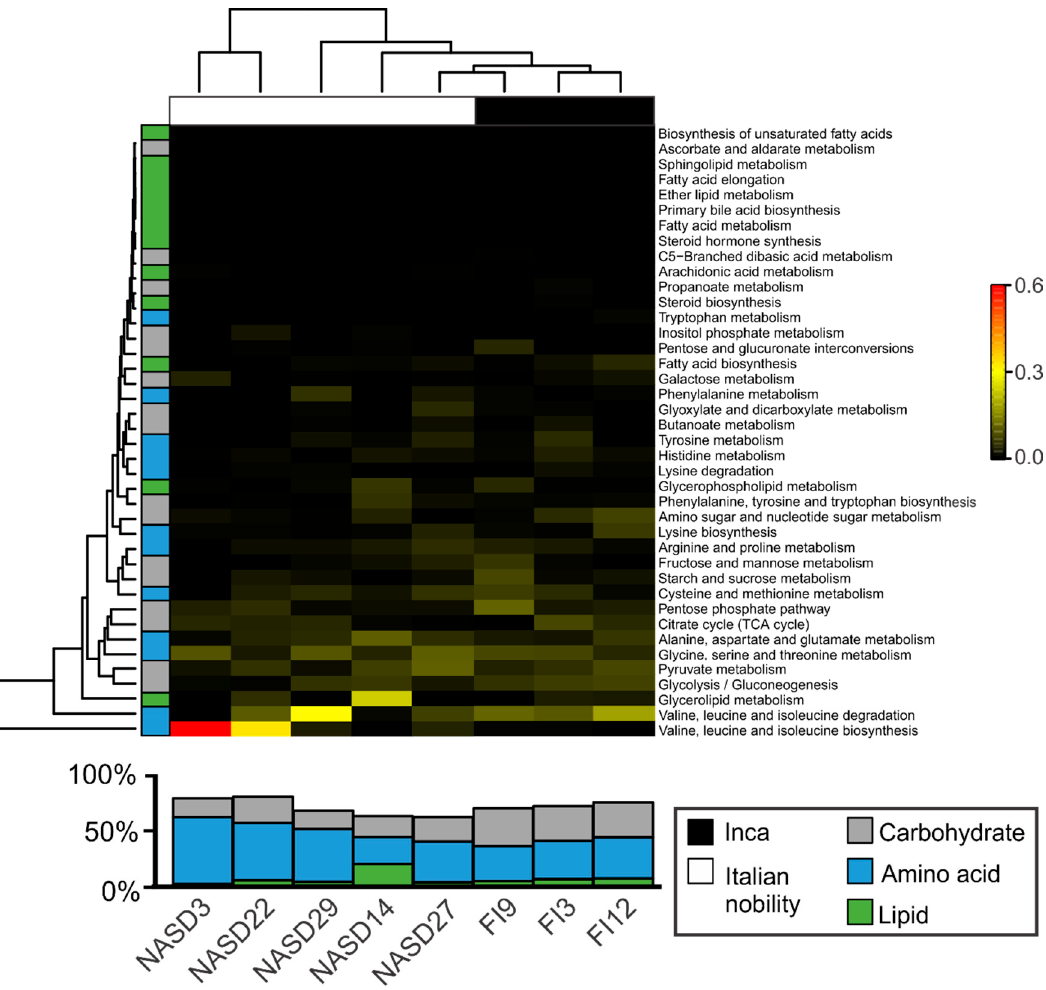
Figure 3. Characterization of the gut functional profiles associated with carbohydrate, amino acid and lipid metabolism in the pre-Inca/Inca and Italian nobility mummies. The top panel shows a heatmap of the Euclidean distances of the Kegg Orthology (KO) counts associated with carbohydrate, amino acid and lipid metabolism. The bottom panel shows the relative abundance of carbohydrate, amino acid and lipid metabolism. Contigs were uploaded to Metagenomic Rapid Annotations using Subsystems Technology (MG-RAST) and annotated using the KEGG database with a minimum identity of 80% and an e-value of 10 × 10 − 5